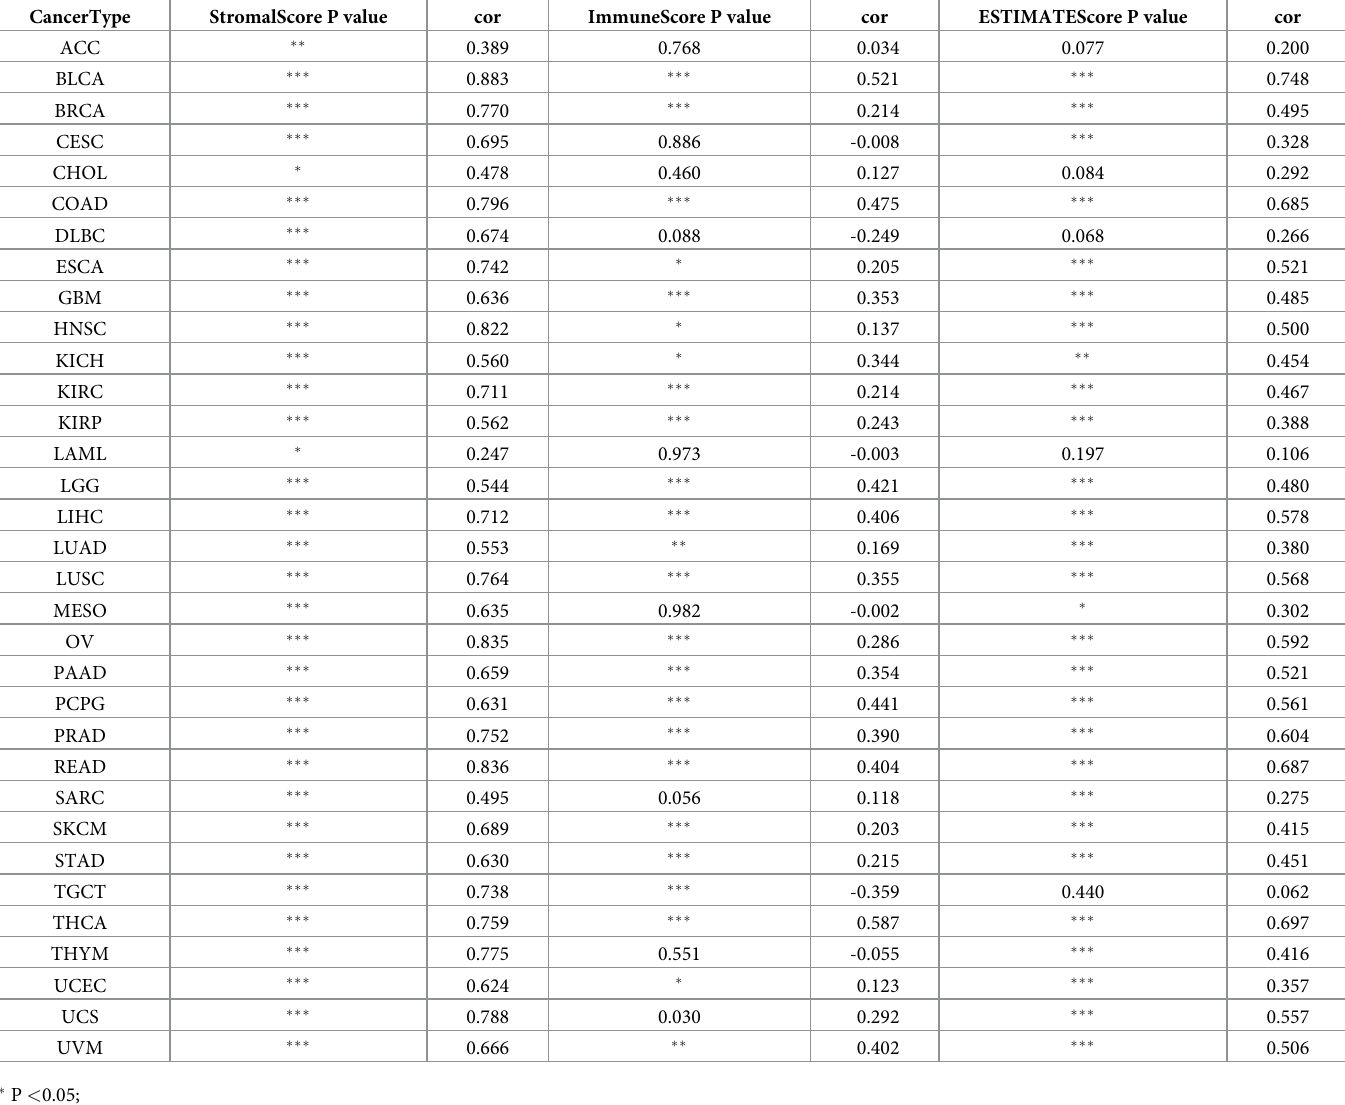
Table 2. Correlation analysis of COL1A1 expression level and TME